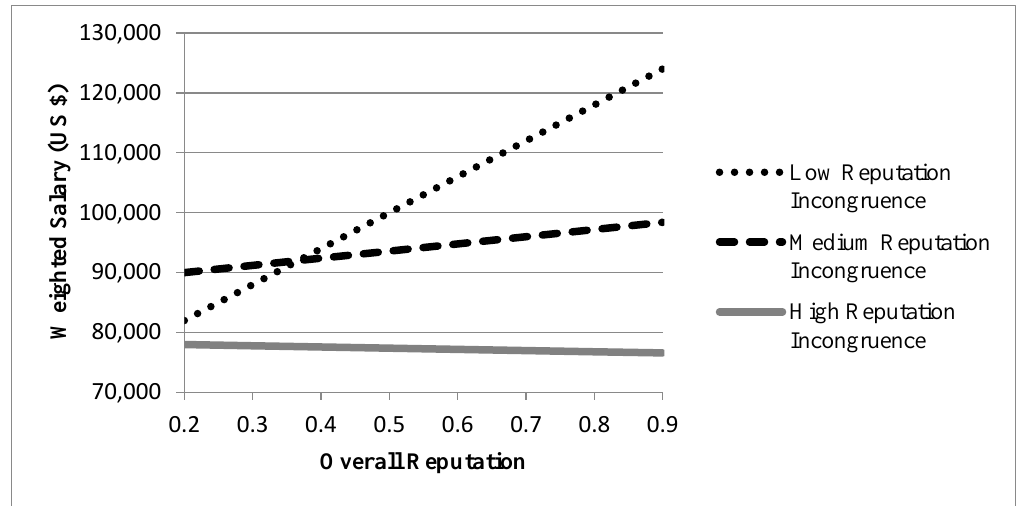
Figure 2. Moderating effect of reputation incongruence in Model 4-2. Note: High/Low groups were determined by cases outside 1 S.D.; Medium group was determined by cases within 1 S.D.